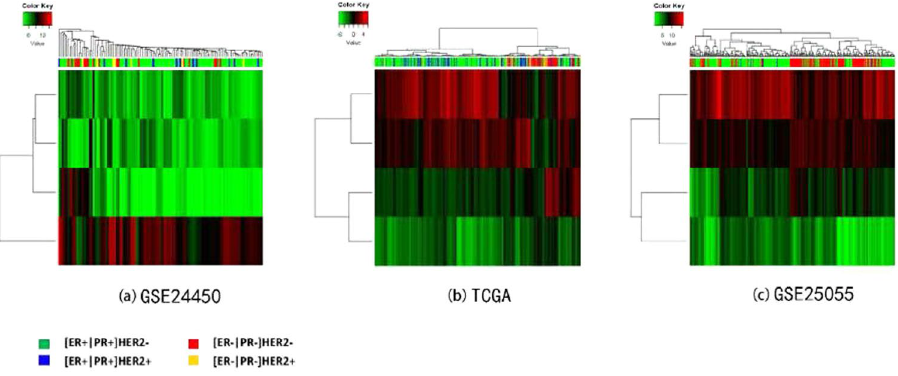
Figure 6. Breast cancers from GSE24450, TCGA and GSE25055 clustered by the four pivotal diagnostic